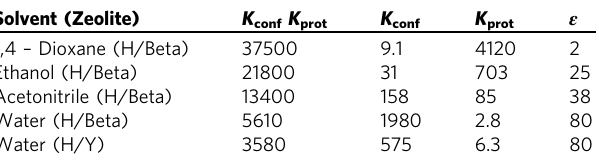
Table 2 Con fi nement and proton transfer equilibrium constants near in fi nite dilution in